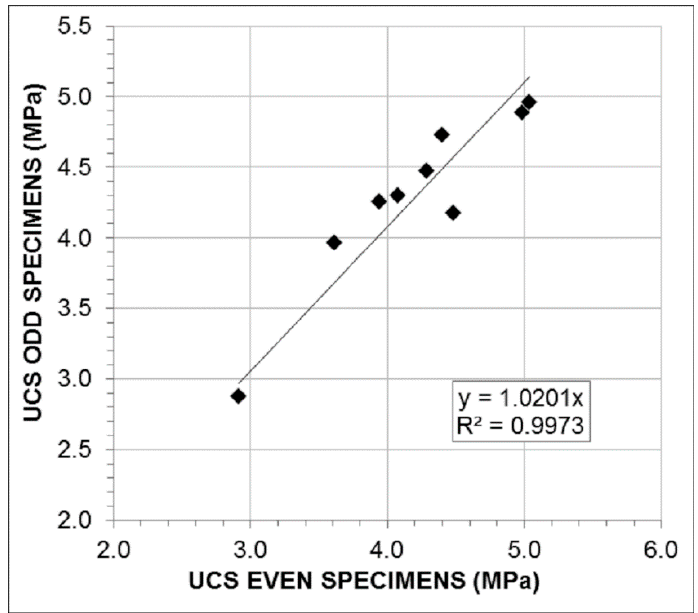
Figure 7. Relationships between mean UCS values from the same batch.